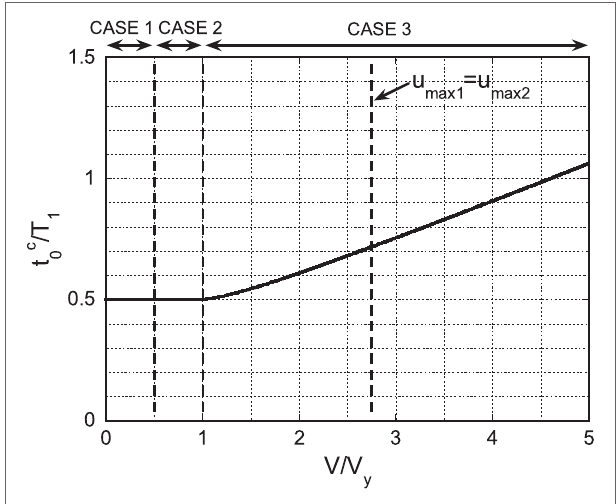
FigUre 11 | interval time between the first and second impulses with respect to input level.